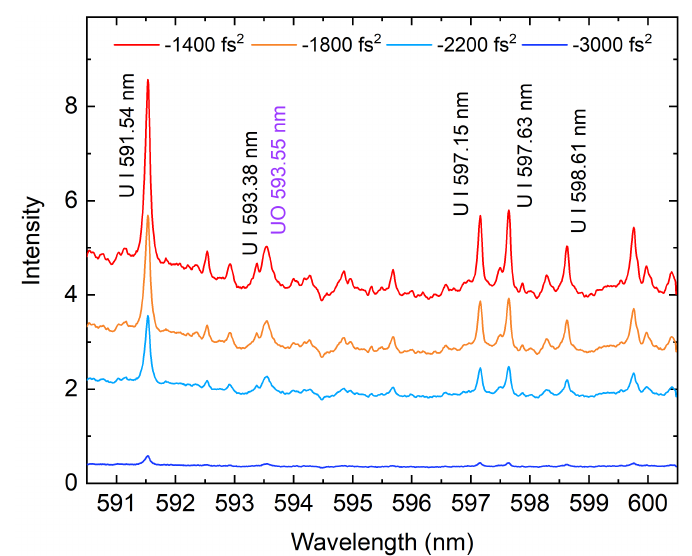
Figure 3. Characteristic uranium emission spectra for various group delay dispersion (GDD) values of the incident laser